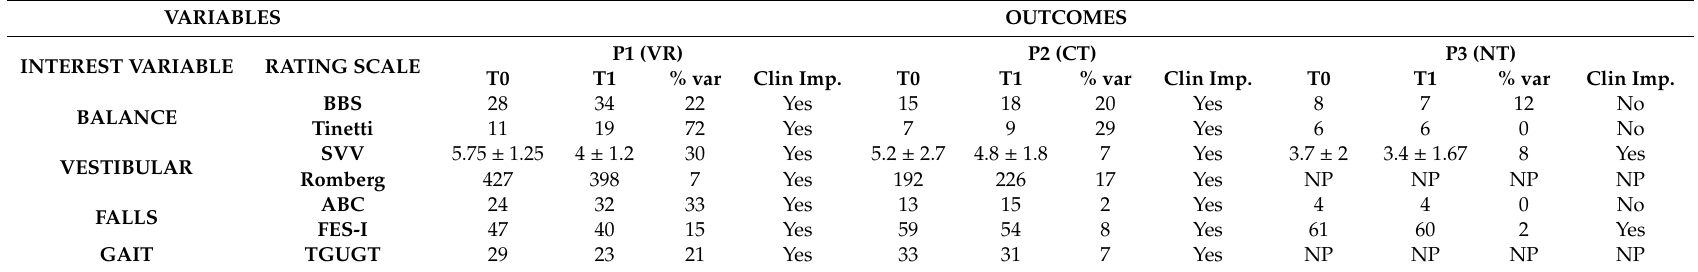
Table 2. Main findings in